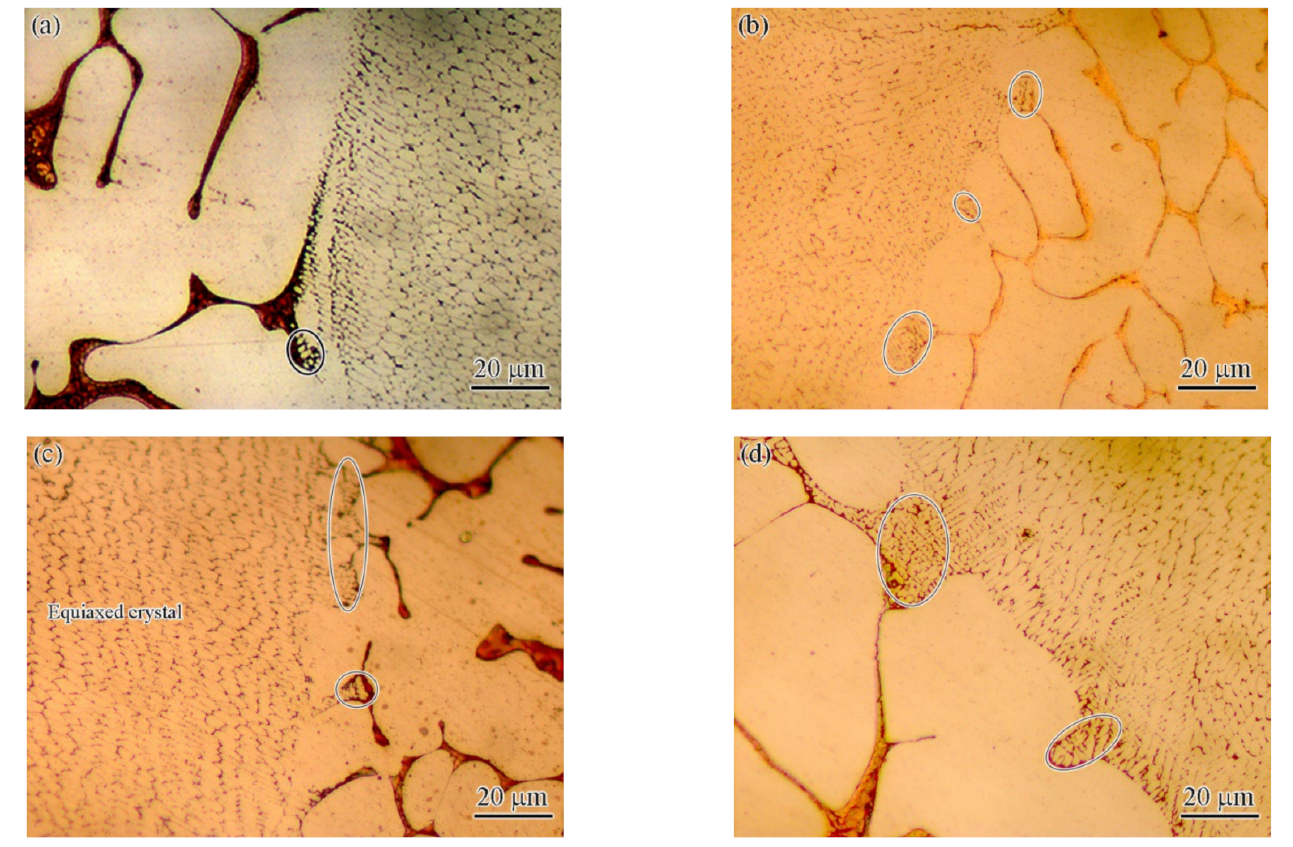
Figure 6. OM microstructure of the fusion line with different input powers: ( a ) 1.65 kW, ( b ) 1.75 kW, ( c ) 1.85 kW, and ( d ) 1.95 kW.